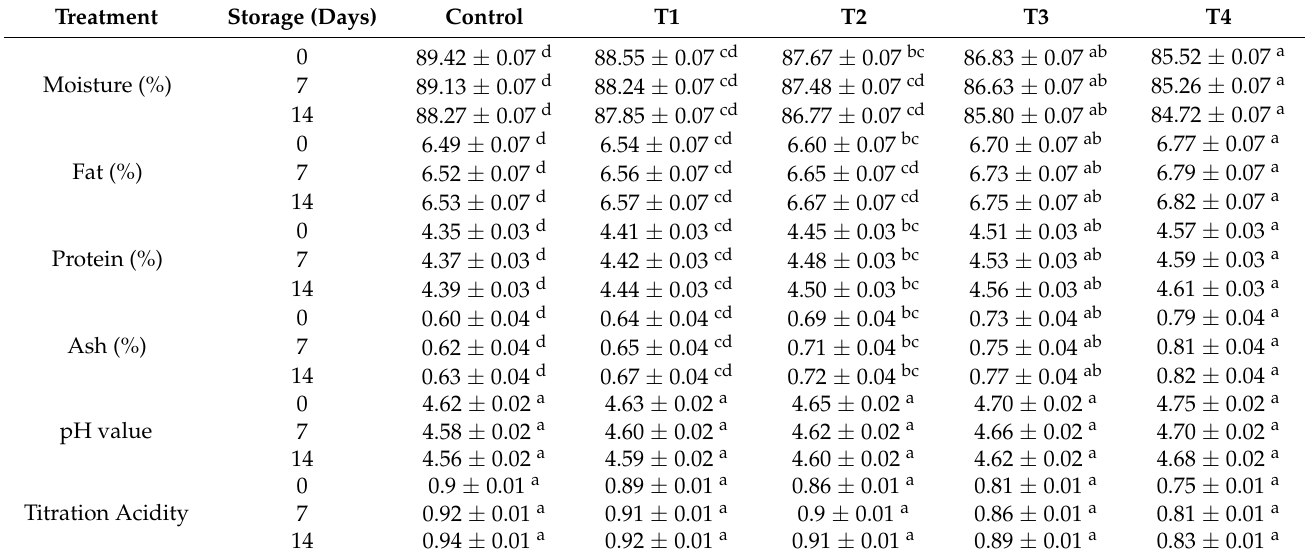
Table 2. Chemical composition, pH, and acidity of yoghurt fortified with different concentration of rosemary extract (mean ± standard deviation) during storage (0, 7, and 14